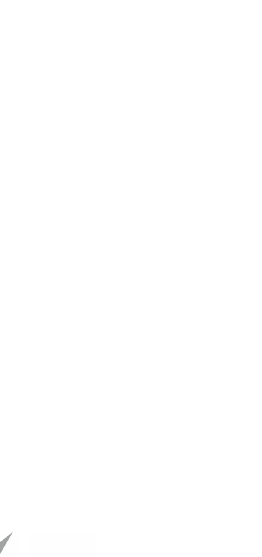
Fig. 9 Effect of Temperature